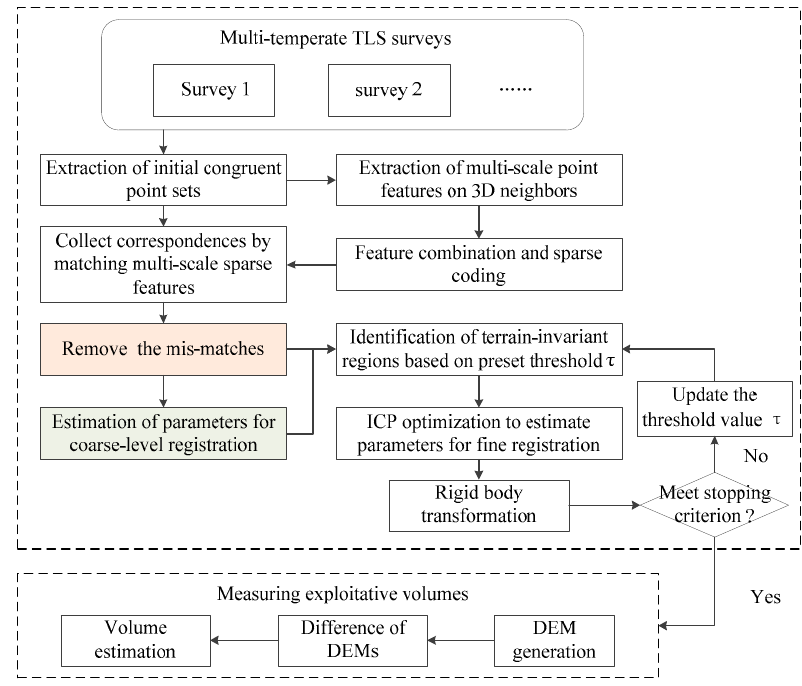
Figure 3. Framework of registering TLS surveys using terrain-invariant regions for measuring exploitative volume over open-pit mines.